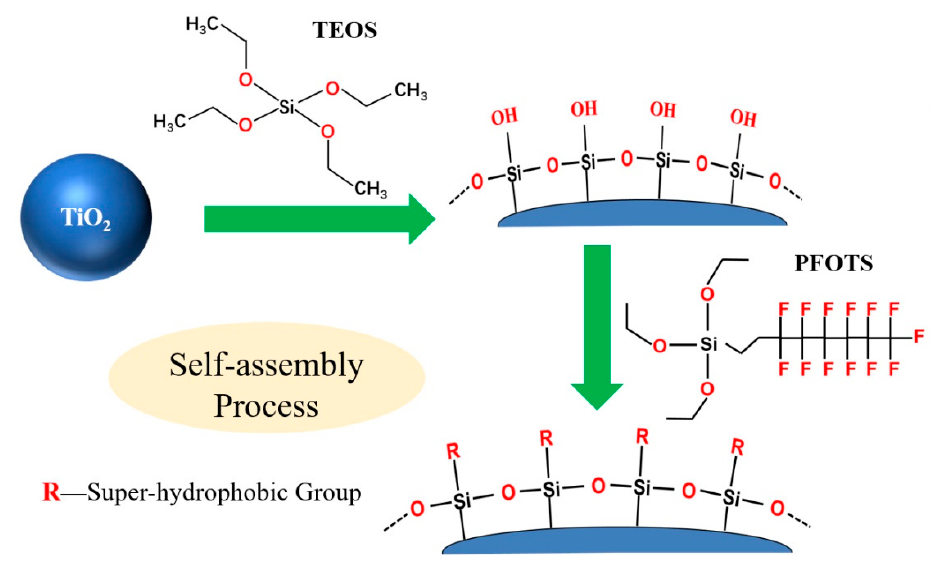
Figure 3. Schematic diagram of the surface modification.